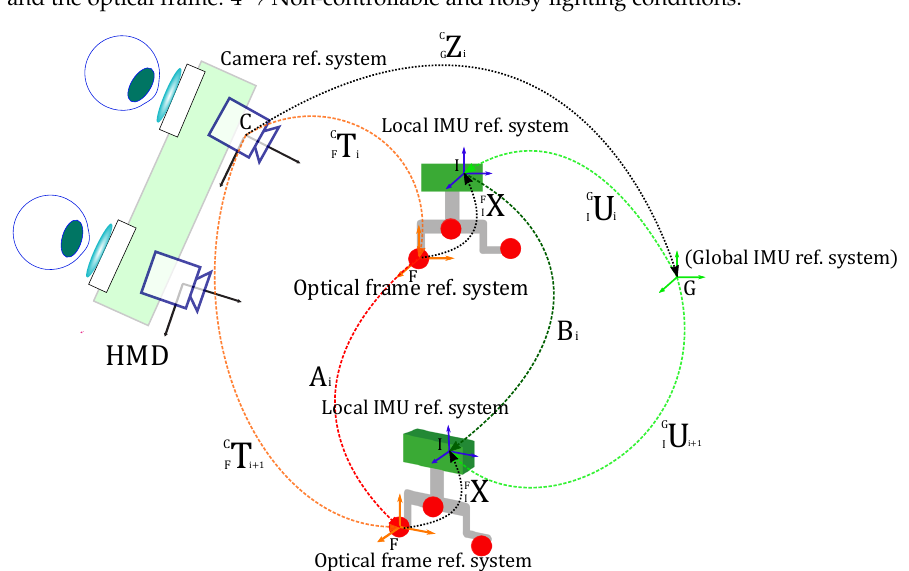
Figure 4. Schematics of the transformations involved in the AX = XB calibration procedure to estimate the orientation between optical frame and